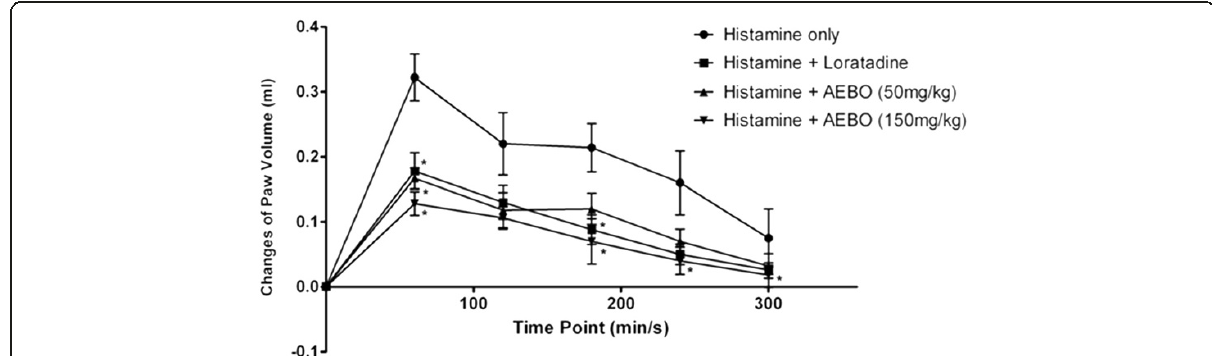
Figure 2 Effect of AEBO on histamine-induced paw edema in rats. Data are expressed as mean ± SEM, n = 6. Paw volume was measured every 60 min until 300 min. * P < 0.05, significantly different from negative control (histamine